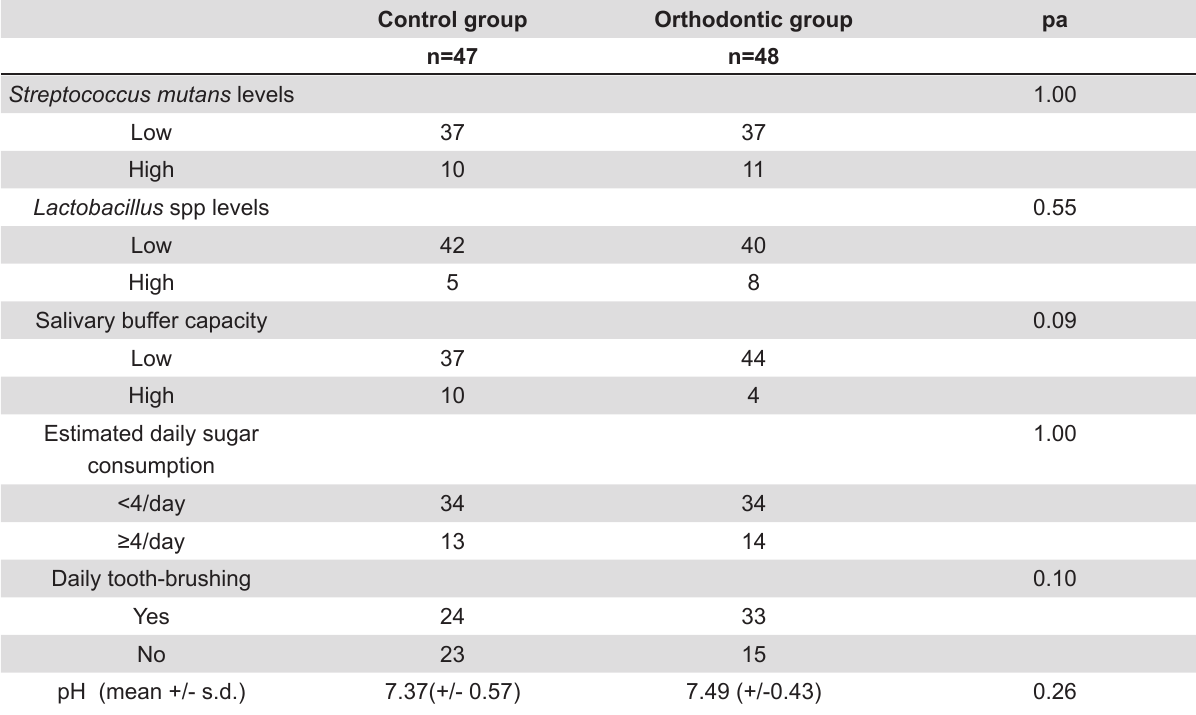
Table 1- Descriptive analysis of variables at baseline